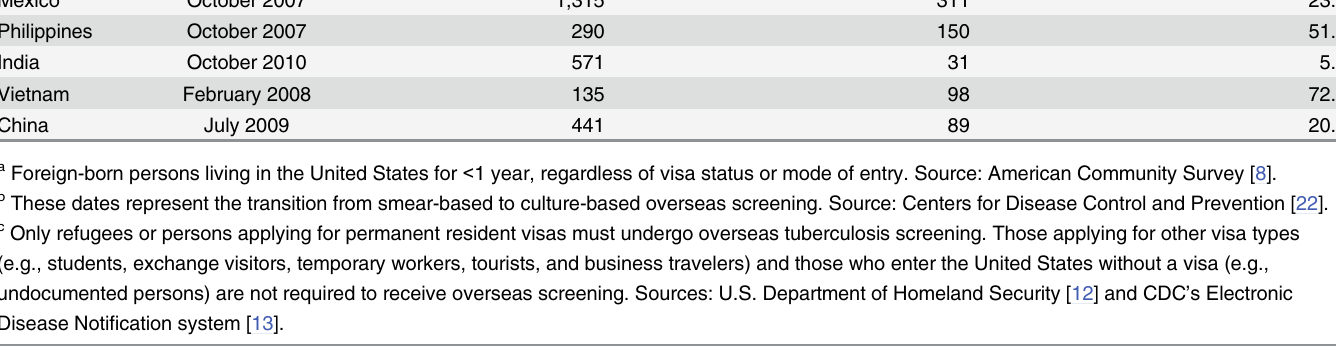
Table 3. Proportion of new entrant population a with overseas culture-based tuberculosis screening, by country of origin, 2007 – 2011. Country Implementation Date b for of Origin